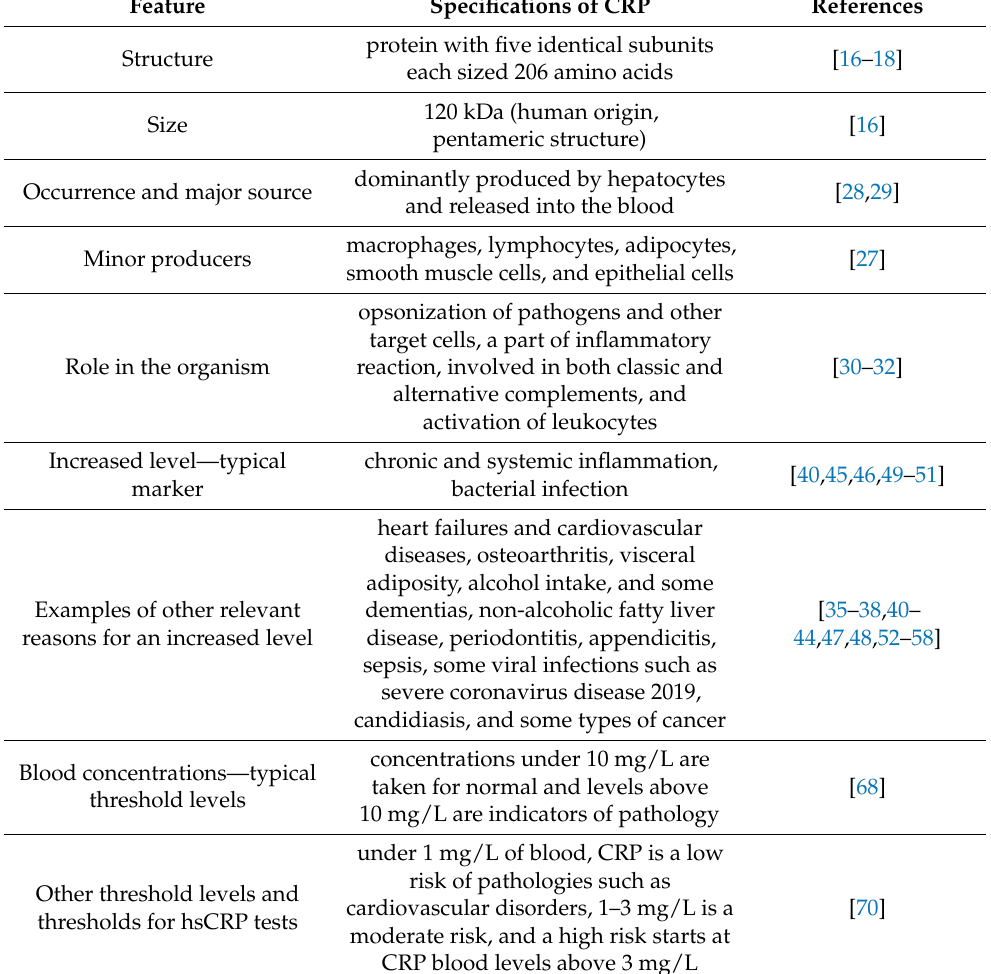
Table 1. Specifications of CRP as a